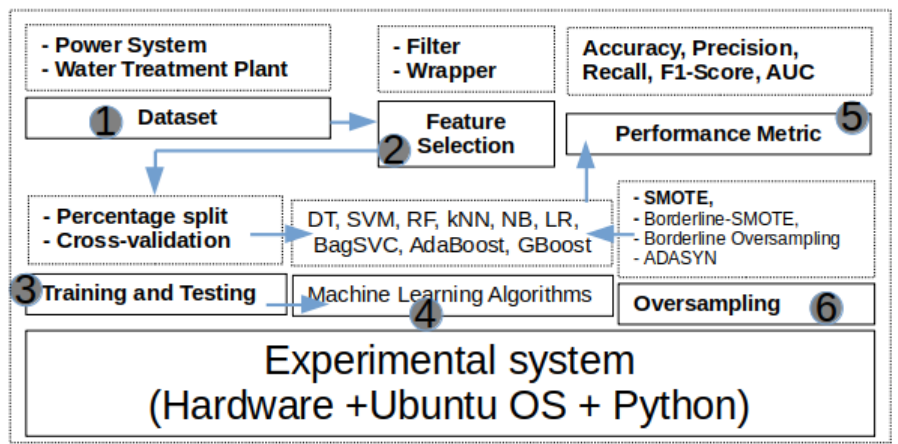
Figure 6. A summary of the steps, structures, and components of the conducted